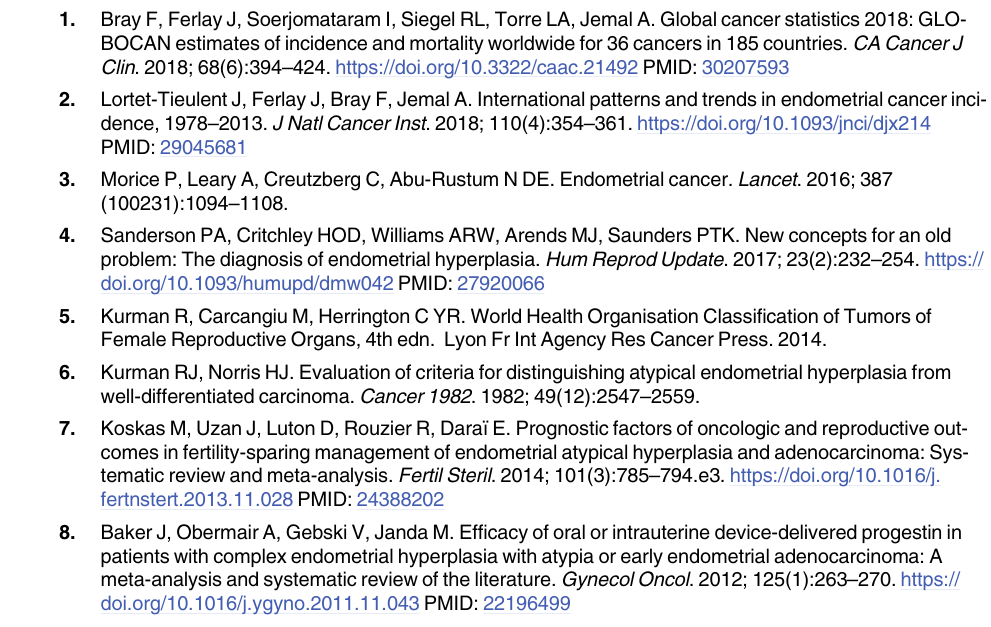
S3 Fig. Forest plot of incidence rates of endometrial cancer diagnosed after three months of endometrial hyperplasia diagnosis in studies with less than 24 months average follow- up. a Premenopausal women. (TIF) S4 Fig. Forest plot of incidence rates of endometrial cancer diagnosed after three months of endometrial hyperplasia diagnosis in studies with more than or equal to 24 months average follow-up. b Postmenopausal women. c LNG-IUS (levonorgestrel intrauterine system) treated group. d Oral progesterone-treated